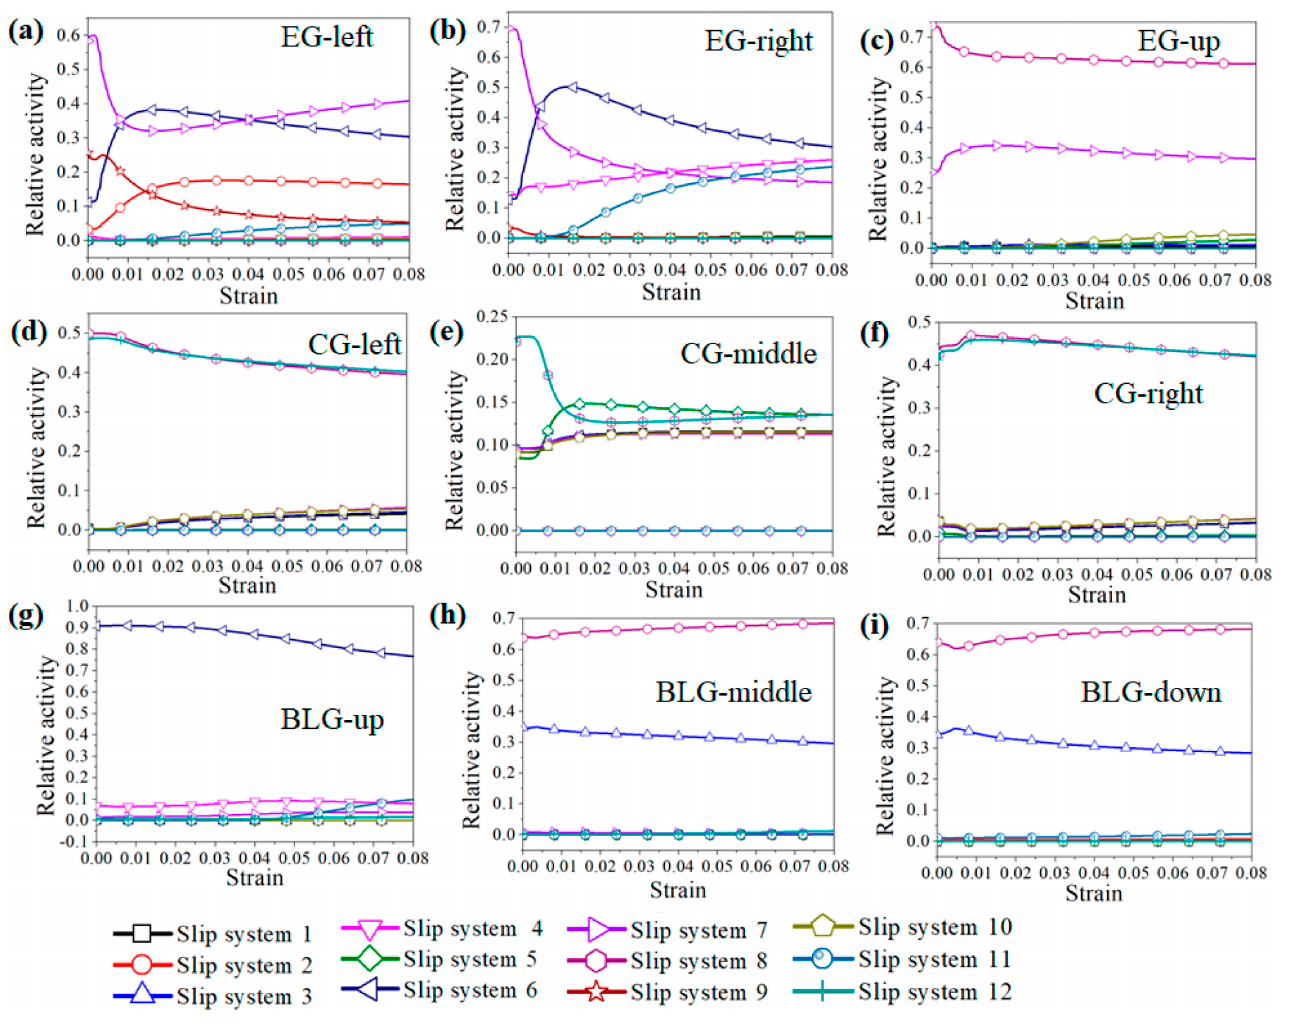
Figure 15. Activation of slip systems for different grain boundary morphologies: ( a – c ) triple-junction GB of EGs; ( d – f ) parallel GB of CGs; ( g – i ) transverse GB of